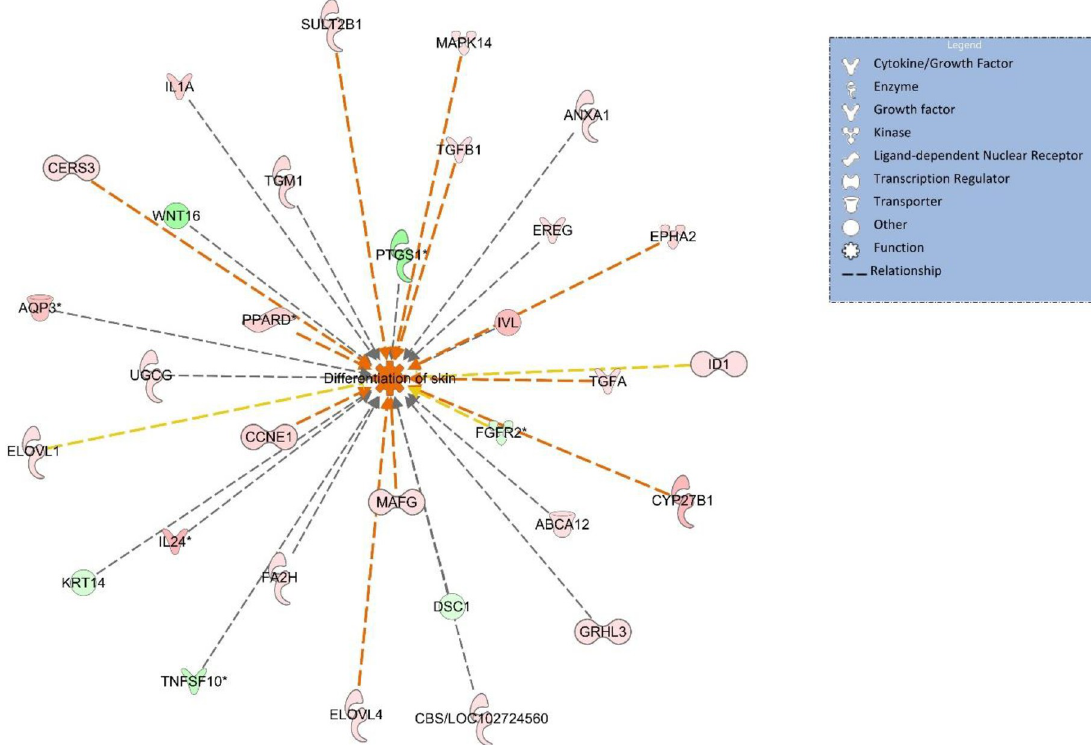
Fig 3. Biological function analysis using IPA predicts activation of skin differentiation from differentially expressed genes shared by NA and HIEO conditions ( p -value: < 0.05, Z-score: 2.3). Z-score indicates the predicted activation (positive value) or inhibition (negative value) of the biological function and p-value was calculated by right-tailed Fisher’s exact test. Figure represents genes associated with the biological function “skin differentiation” which are altered in the uploaded dataset. Genes that are upregulated are displayed within red nodes and those downregulated are displayed within green nodes. The intensity of color in a node indicates the degree of up- (red) or down-(green) regulation. An orange line indicates predicted upregulation, whereas a blue line indicates predicted downregulation. A yellow line indicates expression being contradictory to the prediction. A gray line indicates that direction of change is not predicted. Solid or broken edges indicate direct or indirect relationships, respectively.